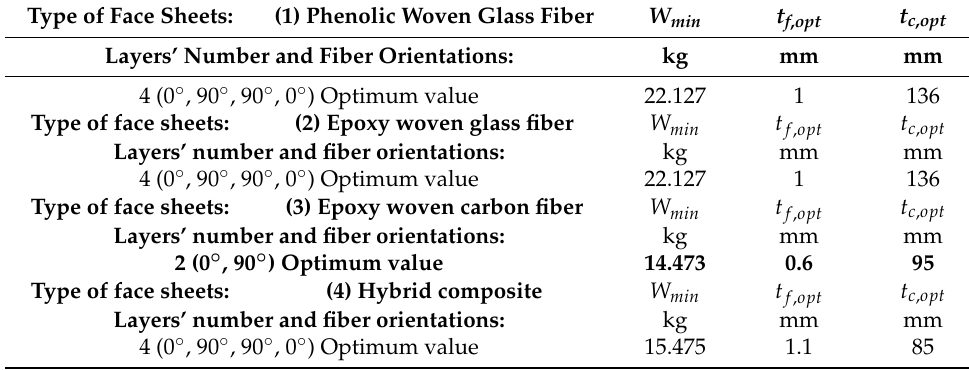
Table 6. Theoretical results for a sandwich plate of the helicopter floor consisting of composite hon- eycomb core (fiberglass/phenolic resin) and composite material face sheets with different numbers of layers and fiber orientations using the Matlab program (Interior Point